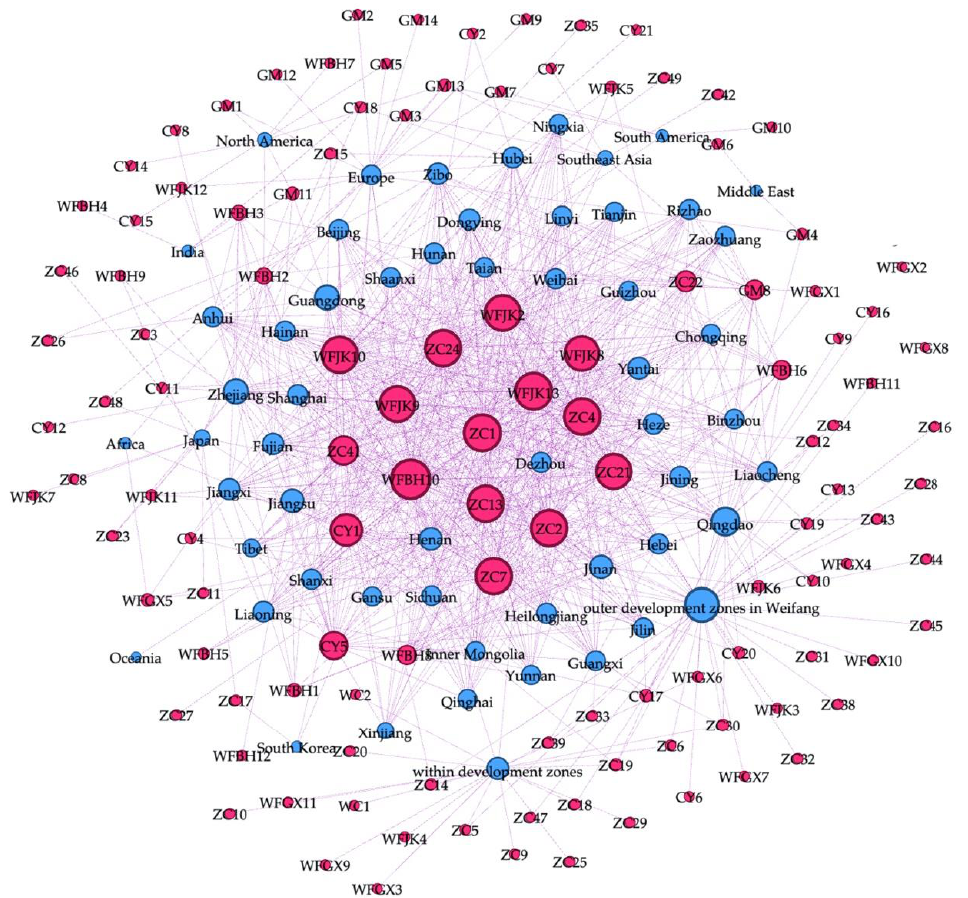
Figure 8. Firms’ sales logistics networks in Weifang’s development zones after the outbreak of the pandemic. Note: The blue and red dots represent the sales destinations and the enterprises in the development zones, respectively; the lines represent the connection between the sales destinations and the enterprises in the development zones. A larger dot indicates that the node has a higher degree centrality in the network. Table 4. Changes in the centrality of sales destinations of Weifang’s development zones during the pandemic.